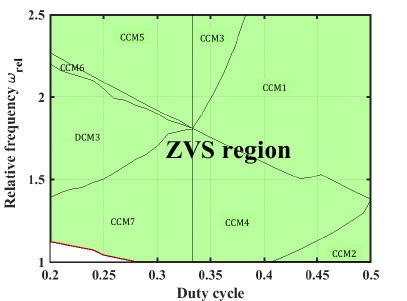
Figure 12. ZVS region and mode boundaries at full load.